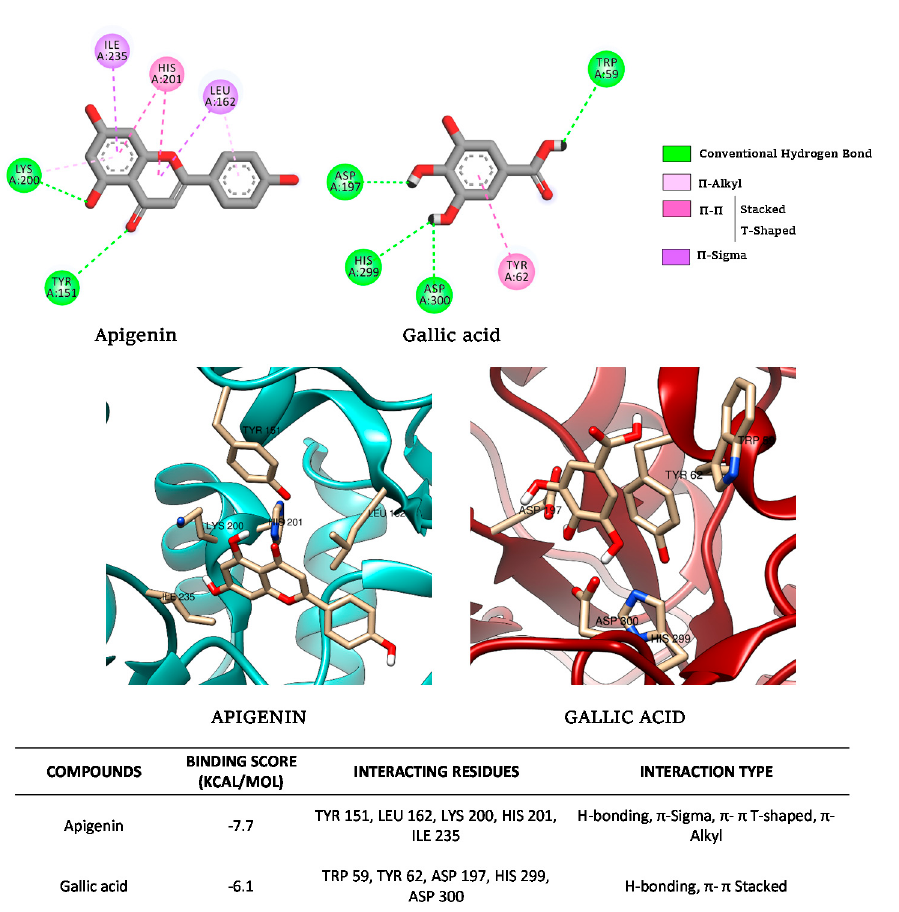
Figure 9. Molecular docking simulations of binding of apigenin and gallic acid to human pancreatic α -amylase.